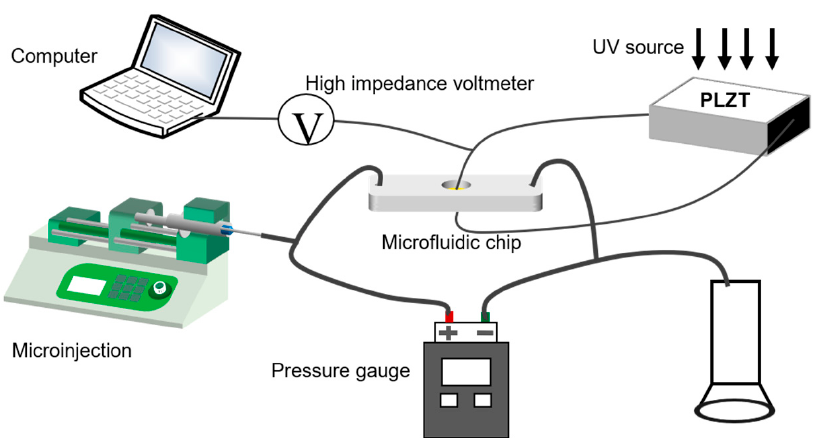
Figure 1. Light-controlled variable damping system.